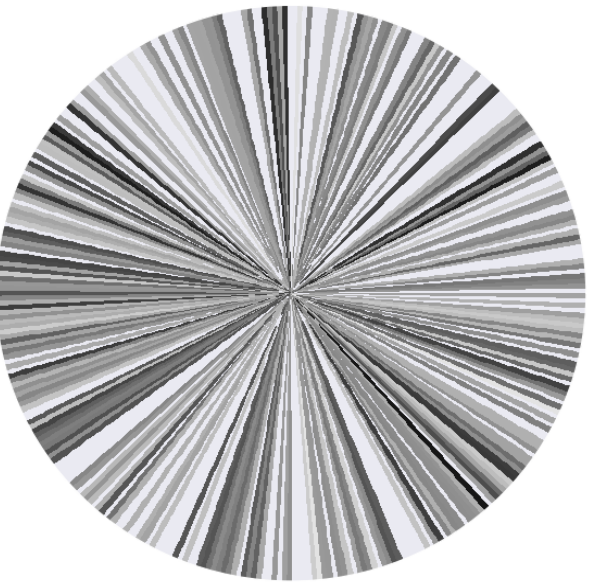
Figure 2. Radial representation showing the relative counts of the genus level of a T2D sample (2000 × 2000 px). The abundances of the bacteria are shown as logarithmically scaled gray levels. The same approach was used to convert the relative counts of the phylum and class levels into radial heatmaps. For the phylum level, 62 phyla of 76, and for the class level 115 out of 228, remained after